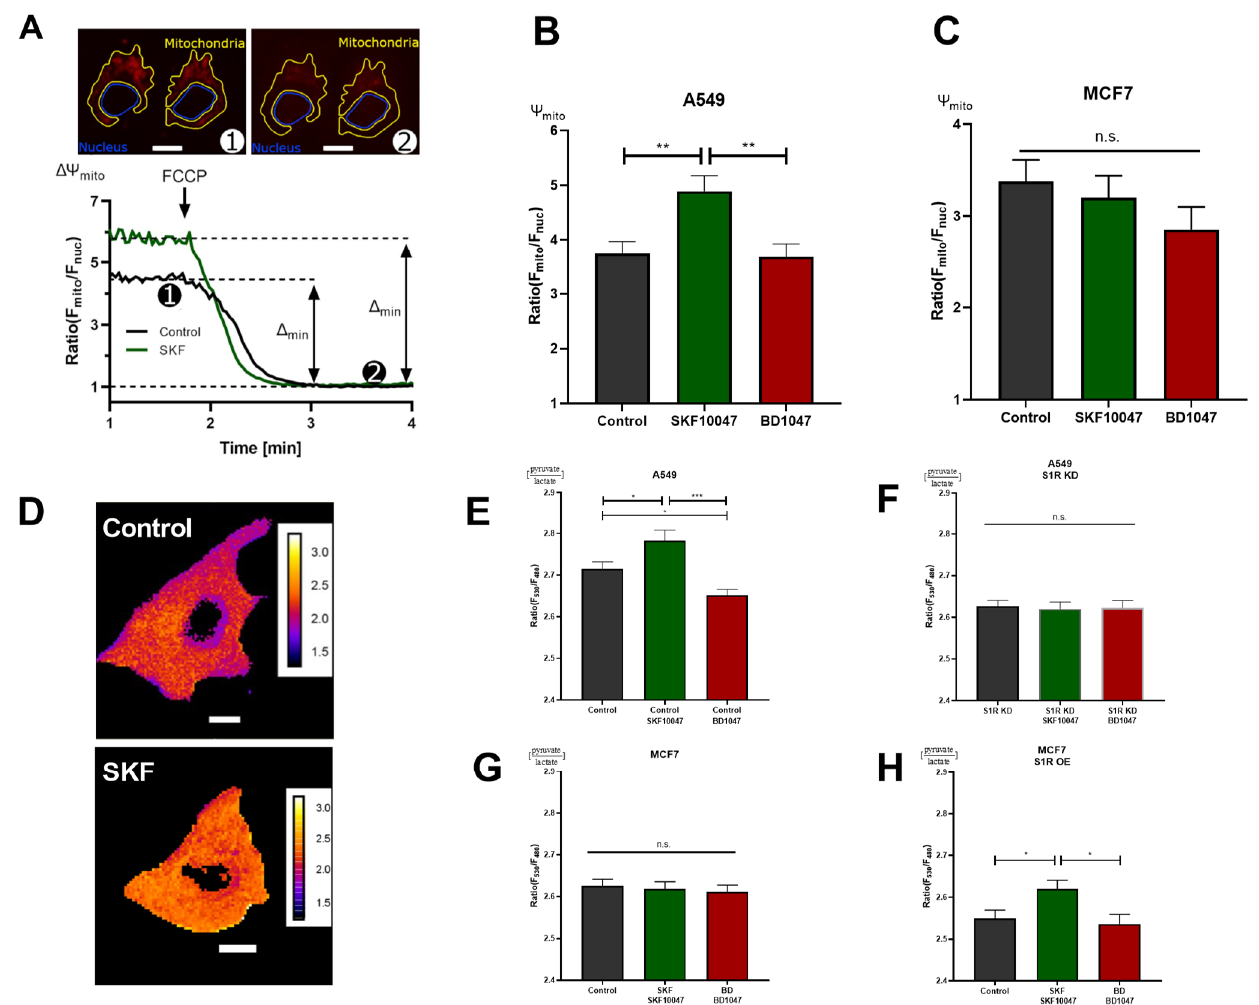
Figure 3. S1R ligands modulate cancer cell energy metabolism. ( A ) Exemplary images of A549 cells stained with TMRM and selected regions of interest (ROI) for mitochondria and nucleus. The inserted white scale bar represents 10 µ m. The experimental protocol with representative ratio traces of mitochondrial to nucleus ROIs is shown for control (black) and control+SKF10047 (green) are shown. Protocol indicated in ( A ) was used to obtain mitochondrial membrane potential for Control (black) and Control+SKF10047 (green) by calculating the change in fluorescence ratio in mitochondria and in nucleus after 1 µ M FCCP treatment. ( B ) Bar graphs with MEAN ± SEM represent the mitochondrial membrane potential for Control (black), Control+SKF10047 (green) and Control+BD1047 (red) in A549 cells and ( C ) in MCF7 cells. ( D ) Exemplary images of A549 cells transfected with ratiometric pyruvate/lactate sensor for Control (above) and Control+SKF10047 (below). The cells have been pseudocolored to represent pyruvate/lactate ratio, calibration bars are inserted on the right-hand side of both cells. The inserted white scale bar represents 10 µ m. ( E ) Bar graphs with MEAN ± SEM represent the cytoplasmic ratio of pyruvate to lactate for Control (black), Control+SKF10047